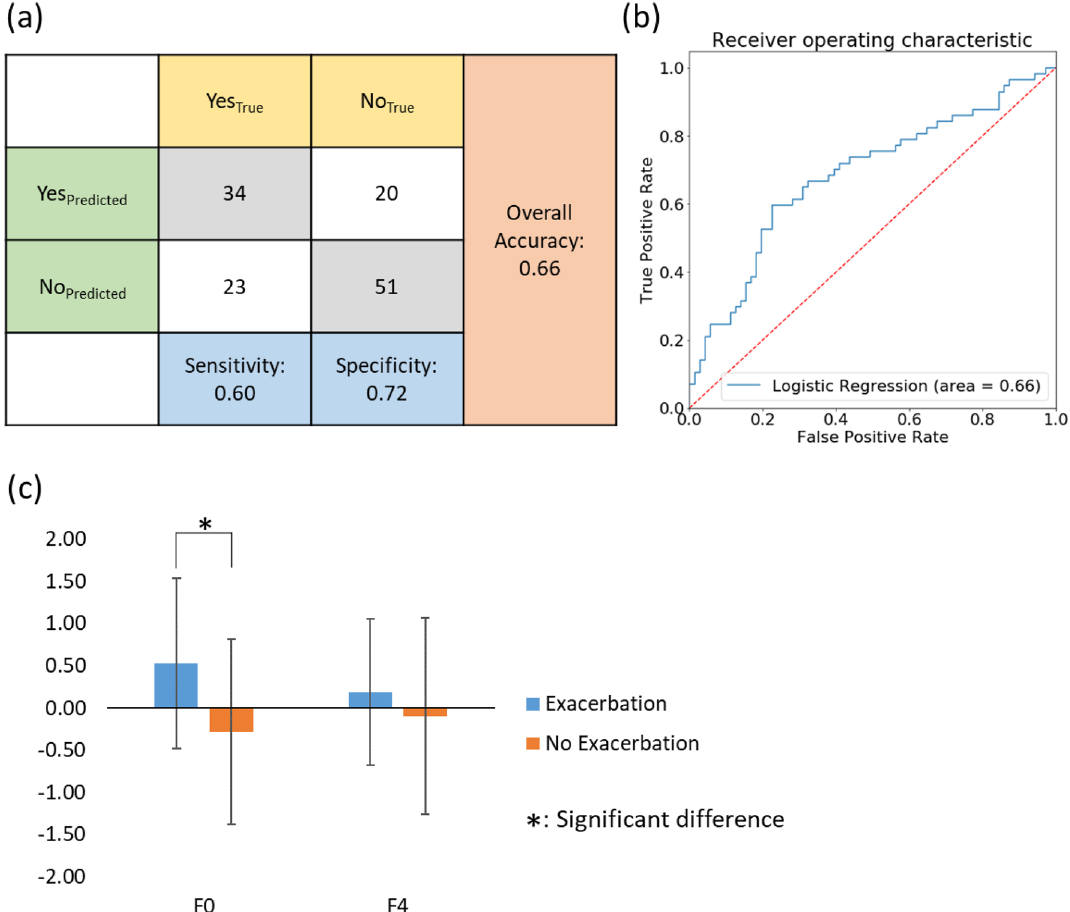
Figure 7. ( a ) A confusion matrix of the logistic regression model fitted for the incident of exacerbation, showing the numbers of correctly and wrongly predicted cases. ( b ) The ROC curve for the logistic regression model. ( c ) Subjects who experienced exacerbation were significantly different than those who did not in terms of